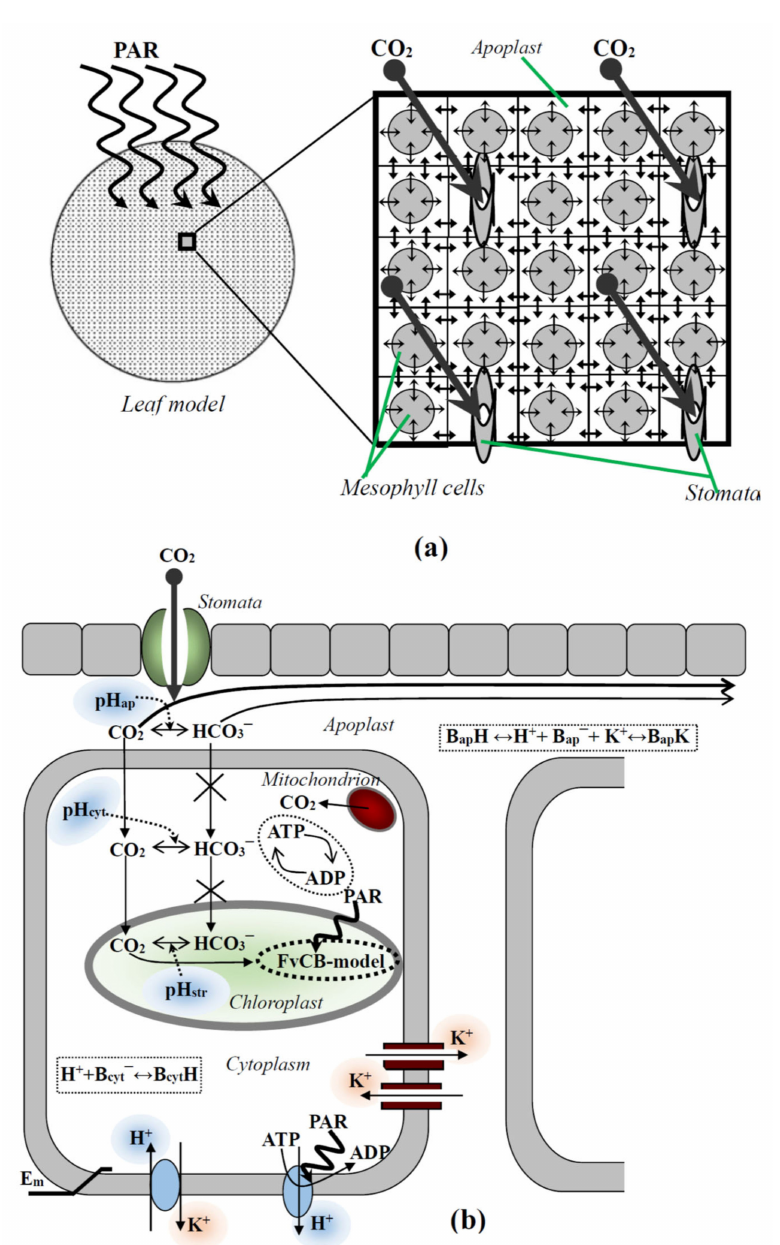
Figure 1. ( a ) A general scheme of the two-dimensional model of photosynthesis in a leaf. The simulated leaf is round and is composed of cells which are connected through the apoplast. Small arrows show transport of carbon dioxide, H + , and K + between apoplastic volumes of neighboring cells and across the plasma membrane. PAR is the photosynthetically active radiation. ( b ) A description of ion and CO 2 fluxes, the activities of ion transporters, buffer capacities, and photosynthetic and respiratory processes simulated by the model. pH ap , pH cyt , and pH str are the pH in the apoplast, cytoplasm, and stroma of chloroplasts, respectively. B cyt − and B cyt H are the free and proton-bound cytoplasmic buffers. B ap − , B ap H, and B ap K are the free, proton-bound, and potassium-bound apoplastic buffers. E m is the gradient of electrical potential across the plasma membrane. FvCB-model is the Farquhar–von Caemmerer–Berry model. The main systems of ion transport at rest, including H + -ATP-ases, H + /K + -antiporters, inwardly rectifying K + channels, and outwardly rectifying K + channels are described in the two-dimensional photosynthetic model. The schemes from [42], with modifications, are